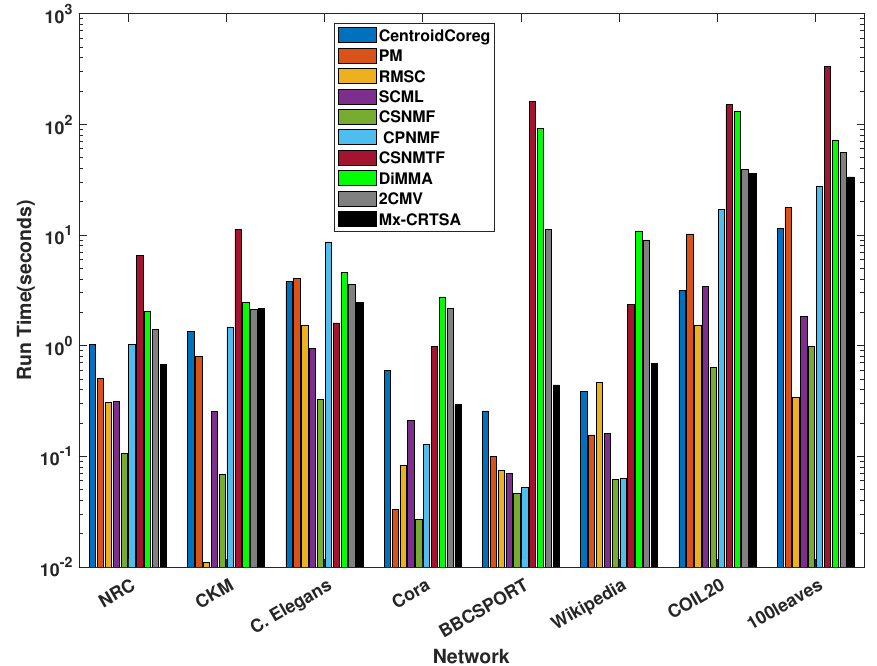
Figure 8. Average run time (in seconds) of the different